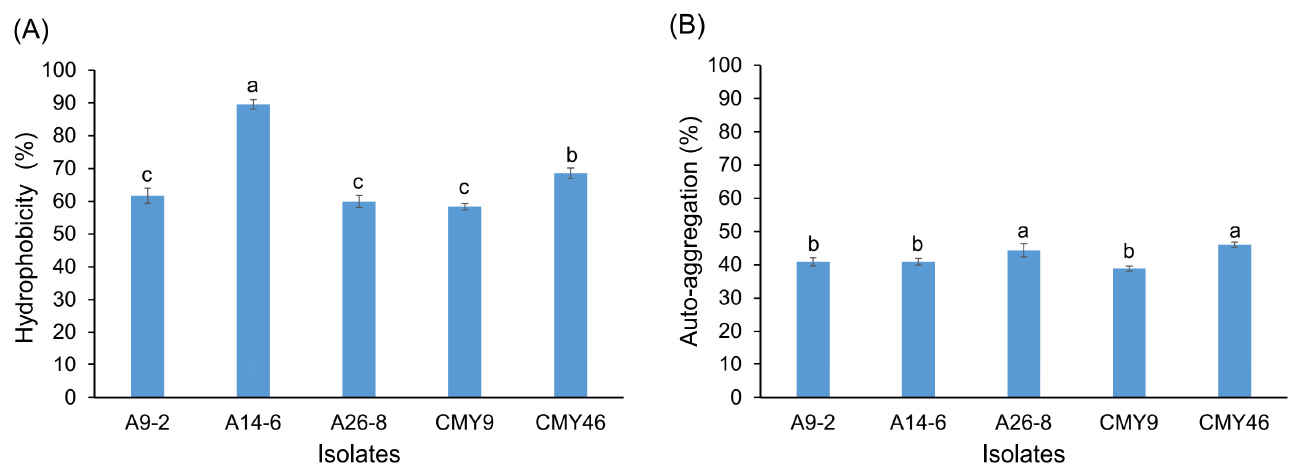
Figure 4. Cell surface hydrophobicity ( A ), and auto-aggregation ( B ) of L. plantarum A9-2, L. pentosus A14-6, L. pentosus A26-8, P. pentosaceus CMY9, and L. pentosus CMY46. Different letters (a–c) indicate significant differences of the values ( p < 0.05).